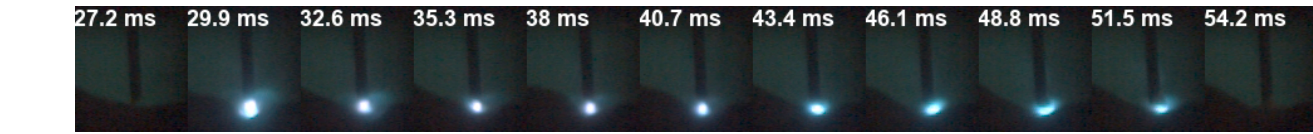
Figure 9. DCEN cycle, time correlates with the waveforms in Figure 8.